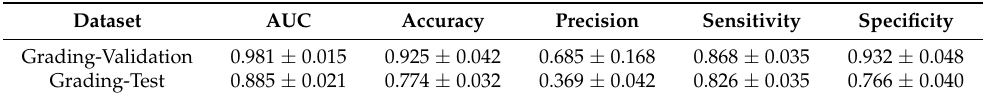
Table 7. Performance in predicting the genetic